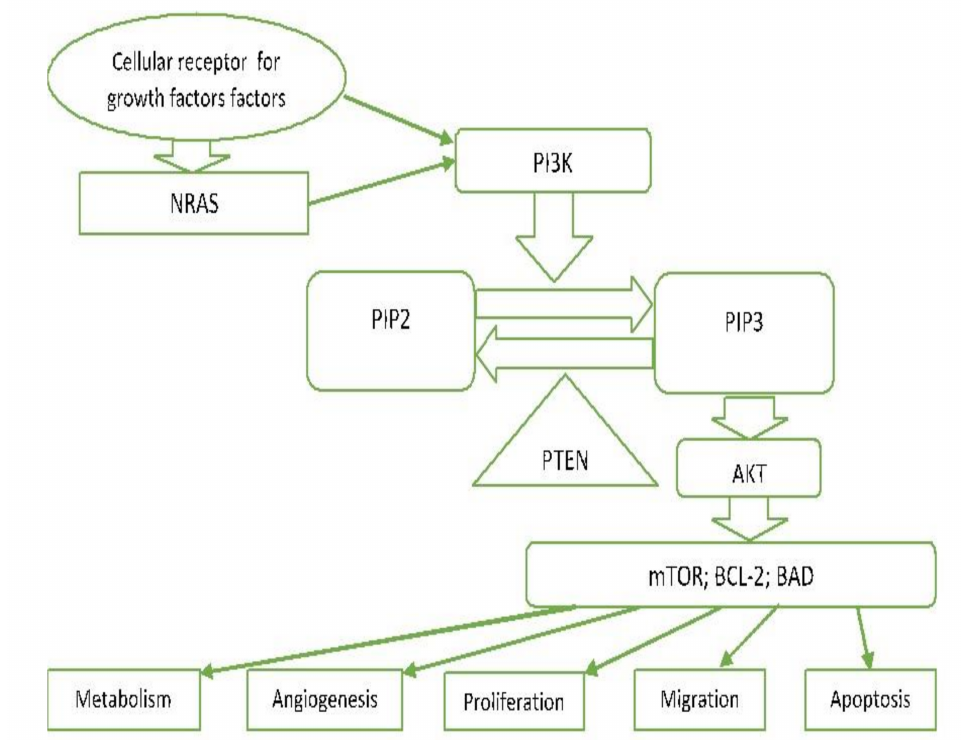
Figure 3. PI3K/PTEN/AKT pathway. NRAS—Neuroblastoma RAS viral oncogene homolog. PI3— Phosphoinositol-3-kinase. PIP2—Phosphatidylinositol 4,5-bisphosphate. PIP3—Phosphatidylinositol (3,4,5)-trisphosphate. PTEN—Phosphatase and tensin homolog deleted on chromosome 10. AKT— Protein kinase B. mTOR—The mechanistic target of rapamycin. BCL-2—B-cell lymphoma-2. BAD— proapoptotic